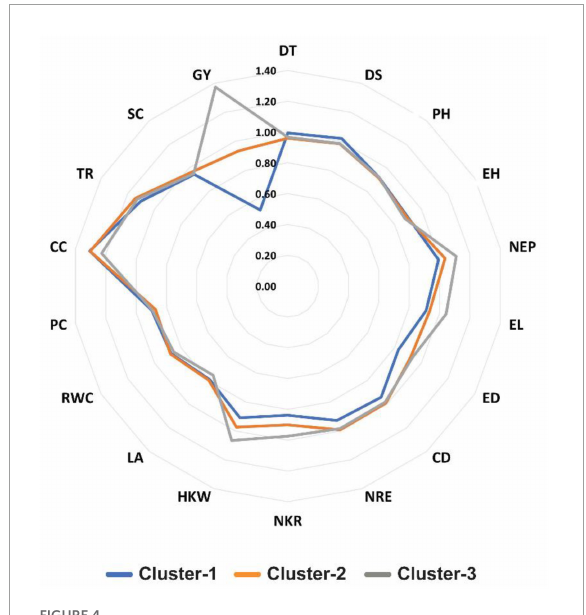
FIGURE4 Radar plot showing drought tolerance index (DTI) values for 18 studied traits in three clusters of 45 maize inbred lines. Number in red color in the figure represent the complete scale of DTI. DT, days to 50% tasseling; DS, days to 50% silking; PH, plant height (cm); EH, ear height (cm); NEP, no. of ears/plant; EL, ear length (cm); ED, ear diameter (cm); CD, cob diameter (cm); NRE, no. of row/ear; HKW, 100-kernel weight (g); NKR, number of kernel/row; GY, grain yield (ardbe/fed); LA, leaf area (cm 2 );